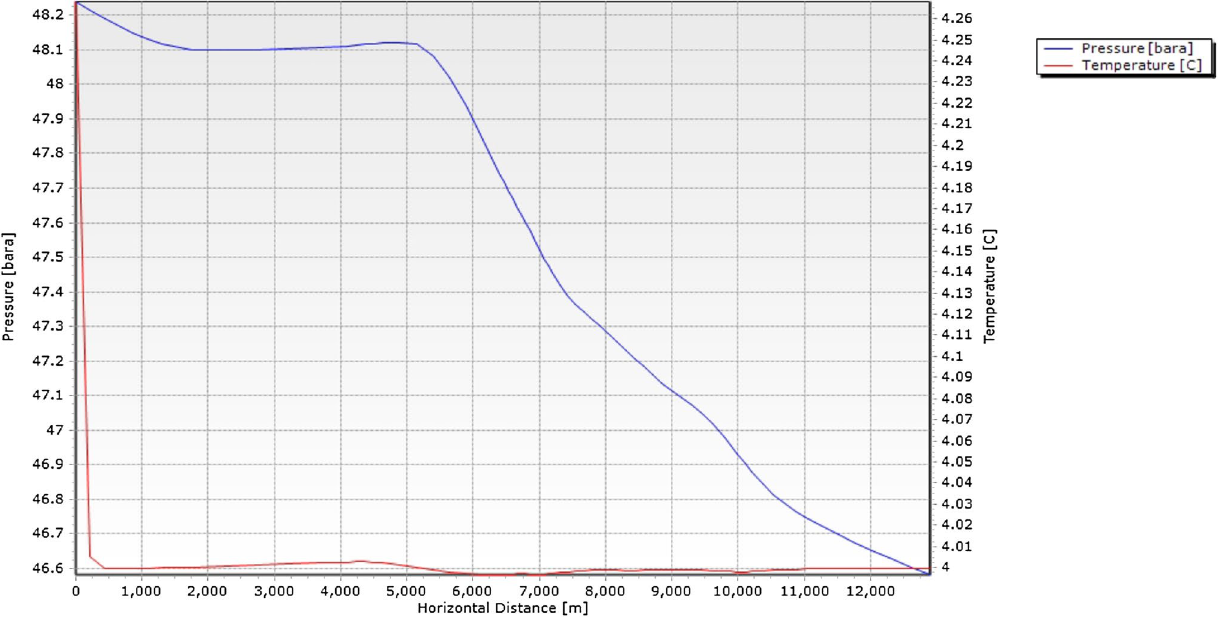
Fig. 14 Pipeline profile after LDHI